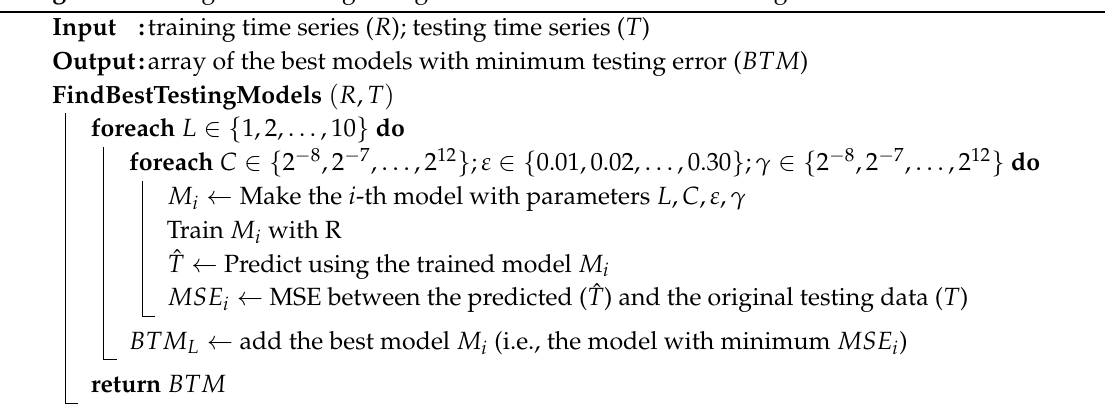
Algorithm 1: Algorithm design for grid search to find the best testing